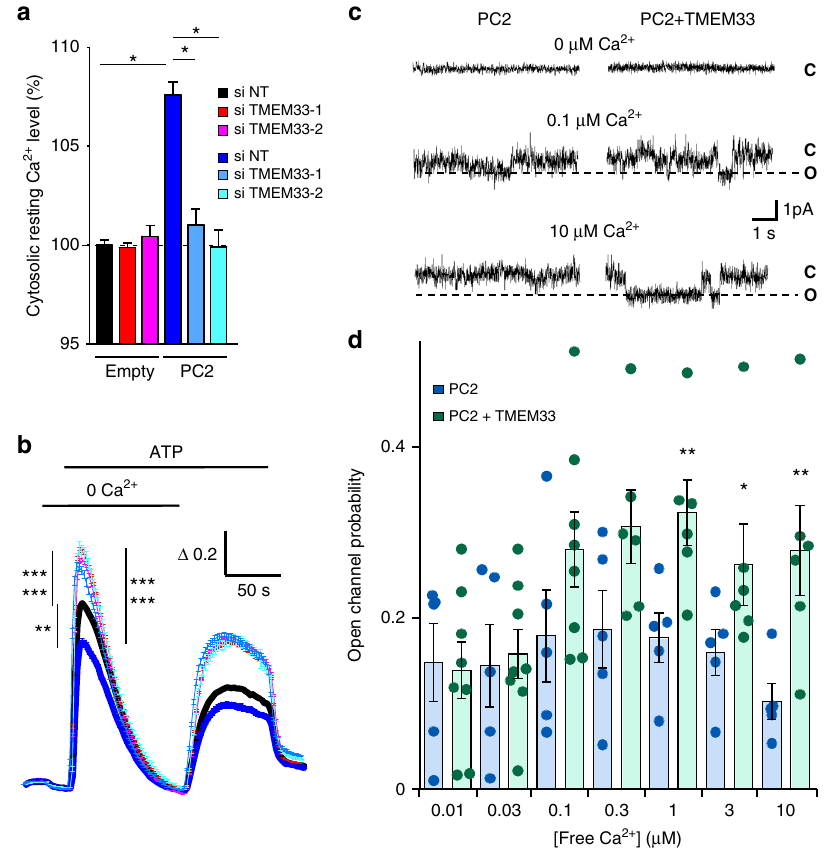
Fig. 3 TMEM33 controls the calcium-dependent gating of PC2. a Increases in cytosolic calcium concentration are expressed as ratios of 340:380 nm fl uorescence signals ( Δ R/R 0 ). Relative (to the siNT empty vector condition; black bar) basal cytosolic calcium levels in PCT cells transfected or not with siRNAs against TMEM33 (red and magenta bars). The effect of PC2 overexpression (as indicated at the bottom of the graph) was also investigated (dark blue bar, siNT and light blue bars: siTMEM33 – 1 and siTMEM33 – 2). Experimental points are available in the data source fi le. Numbers of cells analyzed are indicated in Fig. 2 and ( b ) legends. b ATP-induced calcium transients in the absence of extracellular calcium (siNT, n = 2353; siTMEM33 – 1, n = 2437; siTMEM33 – 2, n = 2201; siNT + PC2, n = 262; siTMEM33 – 1 + PC2, n = 246, siTMEM33 + PC2, n = 322). Same cells as in ( a ). c PC2 channel activity elicited with 0, 0.1 and 10 μ M free calcium on the cis-side (cytosolic) in ER liposomes fused to planar bilayers (holding potential: 0 mV). As previously reported, the slope conductance of the channel was 85 pS when PC2 was activated by cytosolic calcium 7, 10 . C indicates the closed state and O the open state (dashed line). d Open channel probability of PC2 measured at increasing concentration of free cytosolic calcium (PC2: blue bars and PC2 + TMEM33: green bars). Values are means ± SEM overlaid with dot plots for ( d ). One star indicates p < 0.05, two stars p < 0.01 and three stars p < 0.001, with a Student ’ s t test for ( a , b ), as well as a Mann – Whitney test for ( d ) used to evaluate statistical signi fi cance. Source data are provided as a Source Data fi (Fig. 4a, b). Strikingly, TMEM33 signi fi cantly attenuated the amplitude of the GPN response in TMEM33 conditional PCT cells, unlike in parental TMEM33 − / − PCT cells expressing CD8ER (Fig. 4a, b). Moreover, the effect of TMEM33 expression on lyso- somal calcium load was suppressed when PC2 was knocked down (Fig. 4c, d). Third, TMEM33 expression produced an increase in the size of endolysosomes (Supplementary Fig. 4c – f). Fourth,